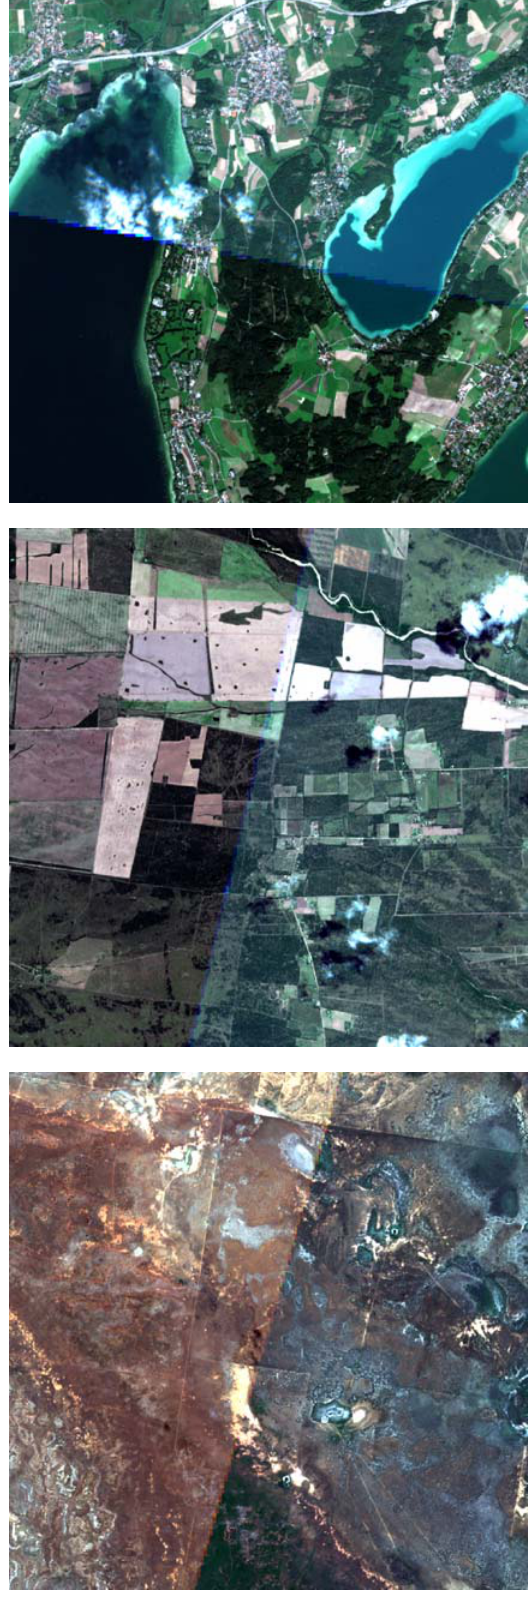
Figure 2. Results of the radiometric harmonization process of Sentinel-2 data (32768 spectral bins) showing from top to bottom: Dataset Germany, Dataset Brazil, Dataset